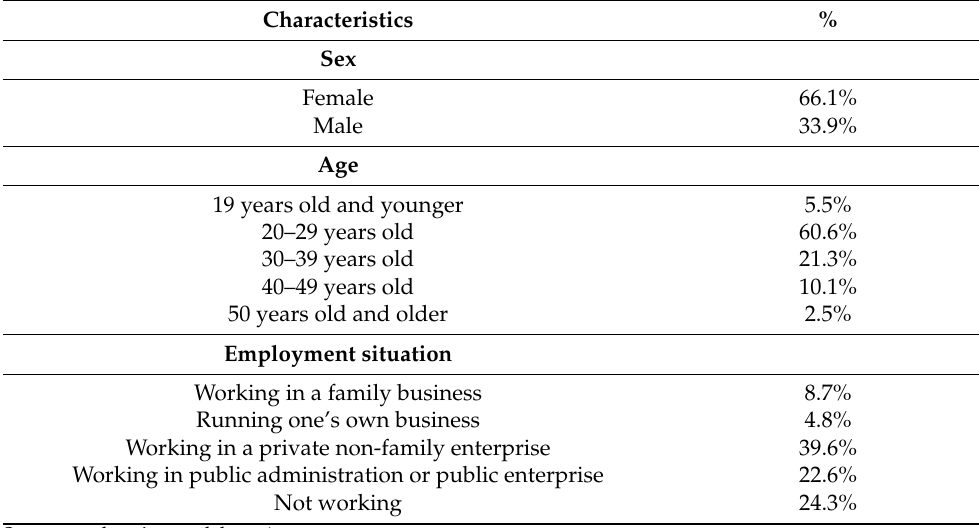
Table 3. Structure of respondents in the second